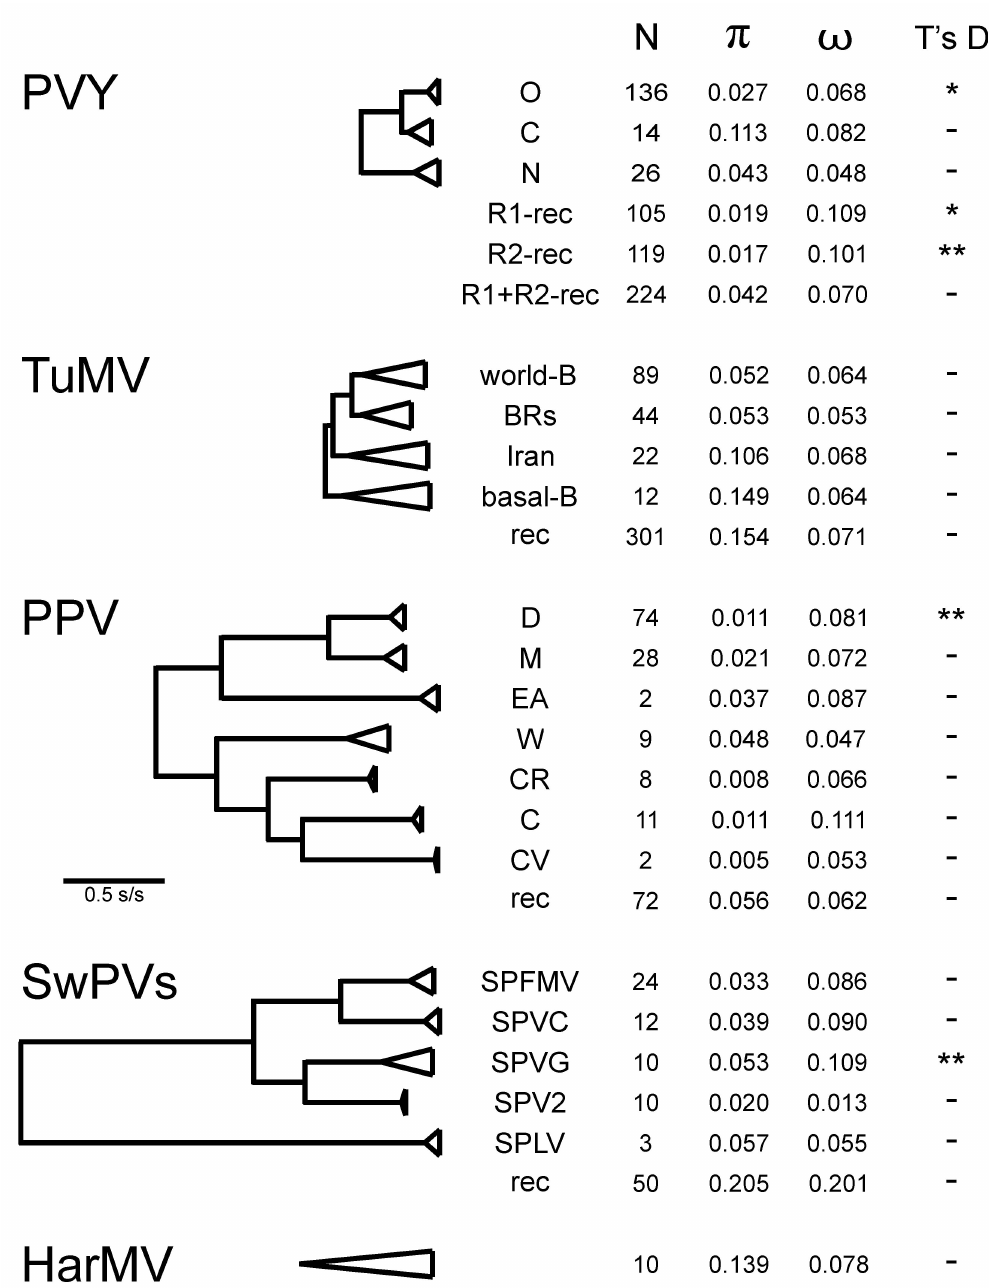
Figure 6. The ML phylogenetic trees (collapsed) of the phylogroups / groups / strains of the non-recombinant (n-rec) ORFs of five potyviruses. The number of ORF sequences for each grouping (N), their average pairwise nt diversity ( π ), and, for each, the ratio of nonsynonymous nt diversity to synonymous nt diversity ω (dN / dS), and the statistical significance of Tajima’s D coe ffi cient for the